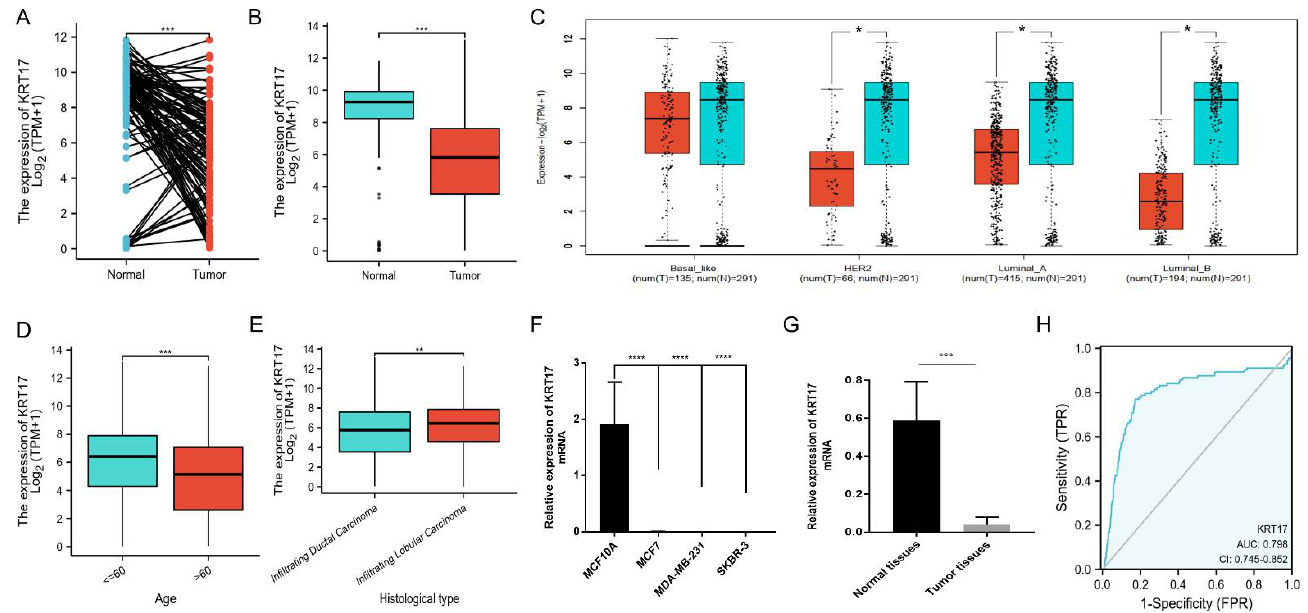
(Figure 1D). Patients with infiltrating ductal carcinoma had lower KRT17 expression than patients with infiltrating lobular carcinoma (Figure 1E).